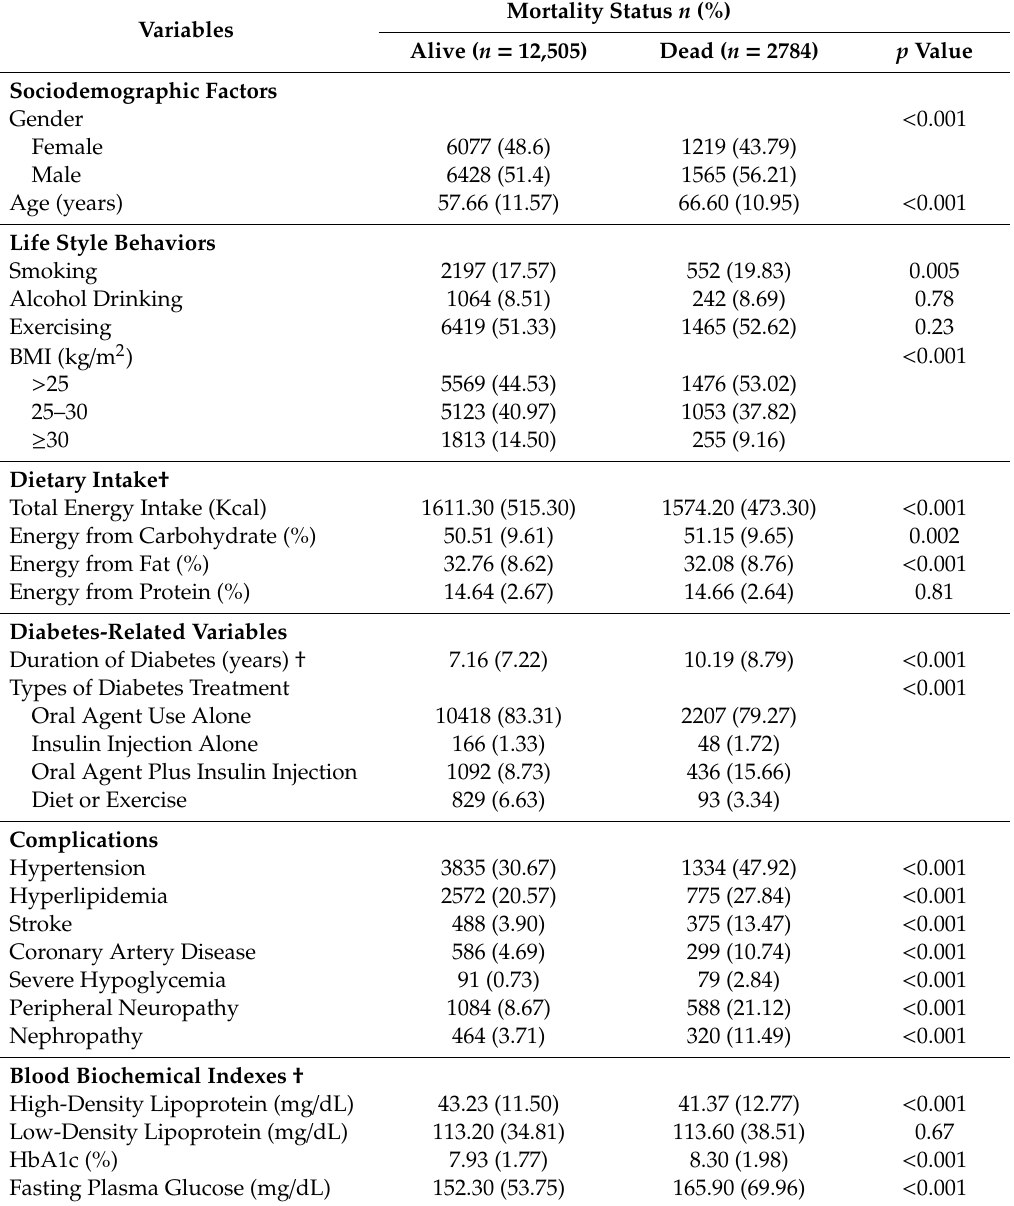
Table 1. The comparisons of baseline sociodemographic factors, lifestyle behaviors, diabetes-related variables, dietary intake, complications and blood biochemical indexes, according to mortality status in patients with type 2 diabetes enrolled in Diabetes Care Management Program of a medical center ( n =